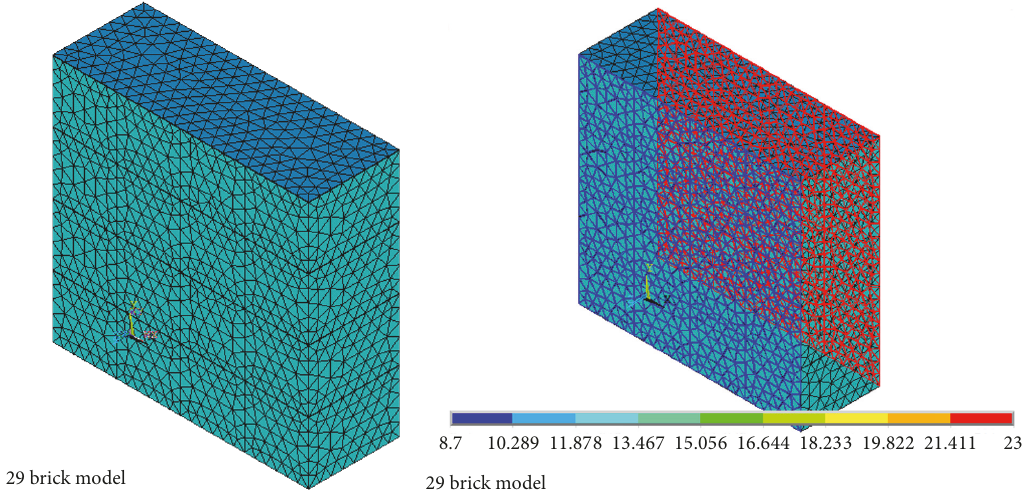
Figure 10: FEM meshes (a) and loading process (b) for the hollow shale block